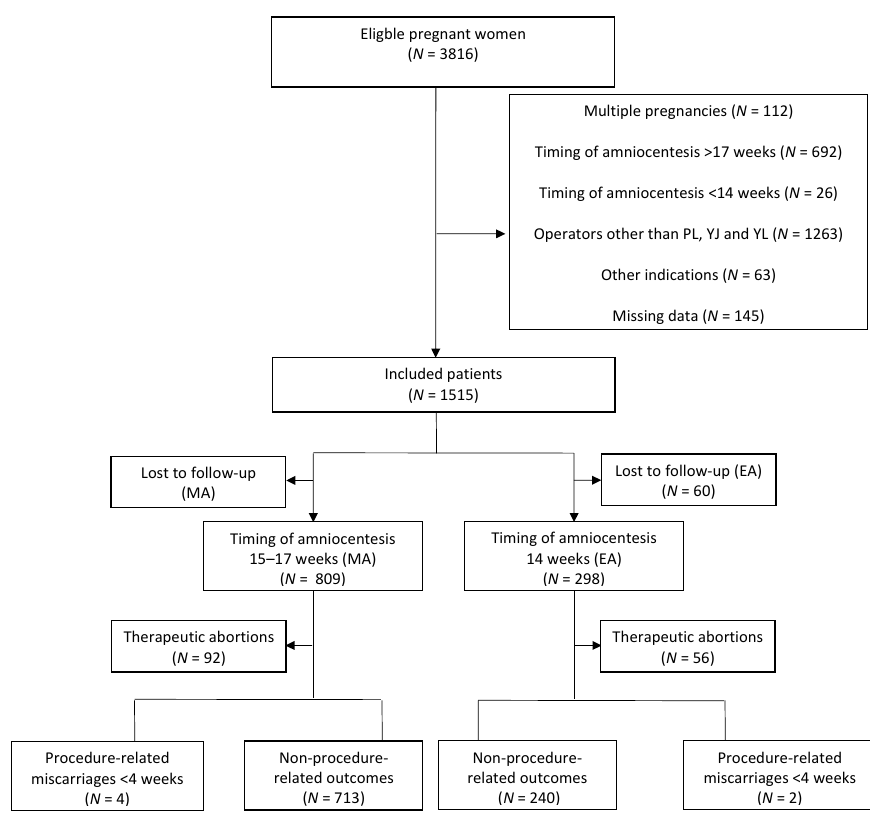
Figure 1. Flowchart of the study population .